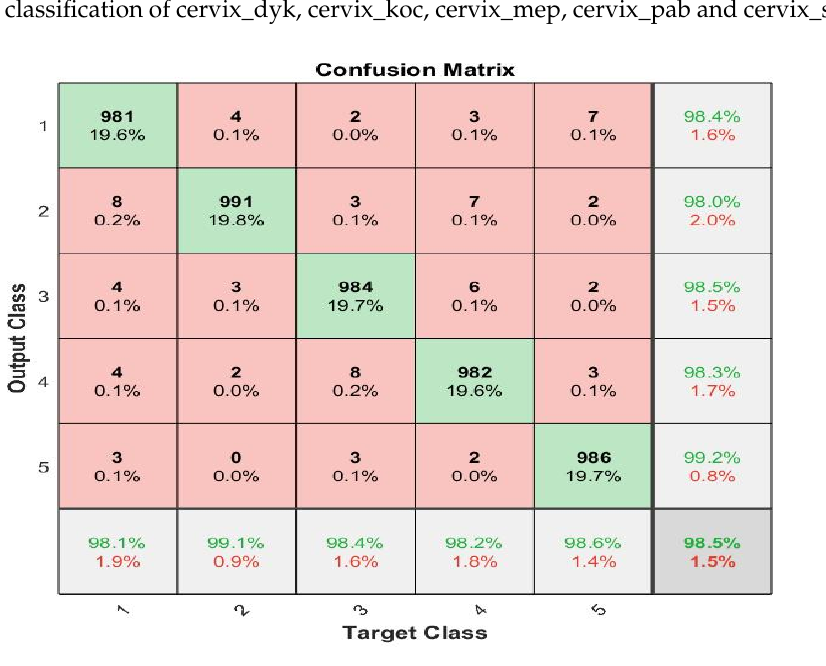
Figure 9. Results of ANN performance based on fused CNN features for diagnosing WSIs of cervical abnormal cells.